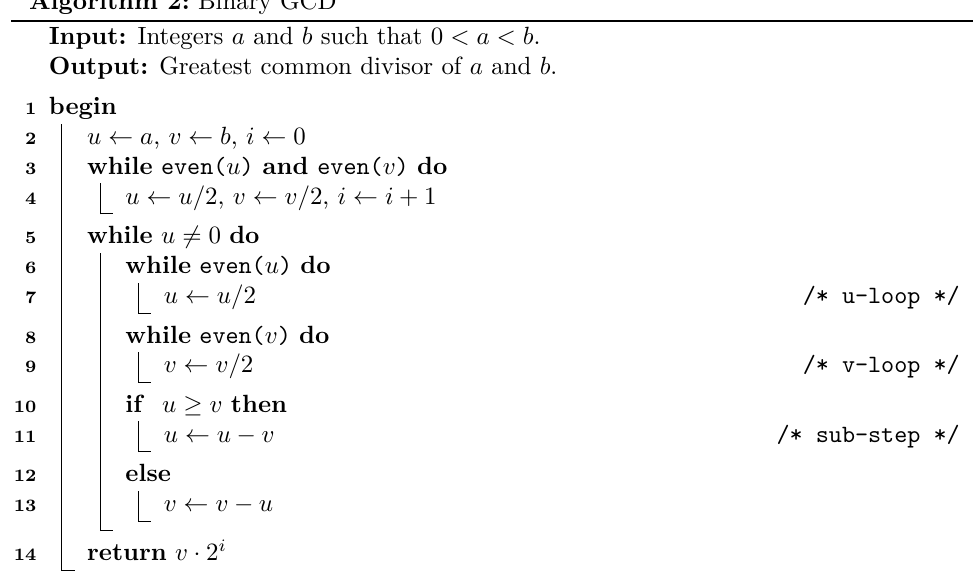
Algorithm 2: Binary GCD